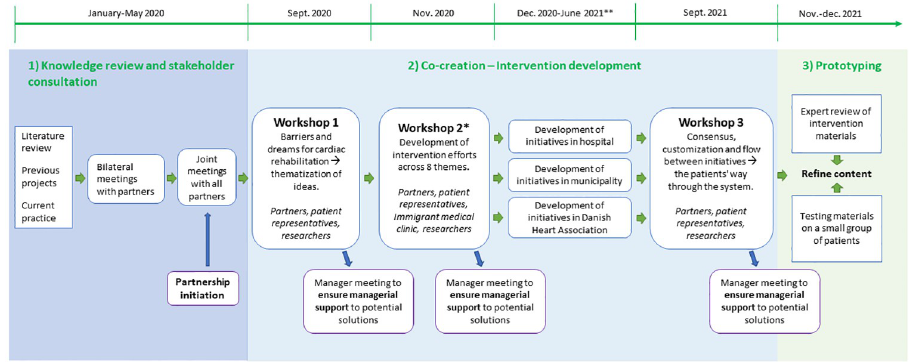
Fig 3. Framework for co-creation and prototyping in a complex intervention. � Virtual workshop do to Covid-19. �� The Cardiac Outpatient Clinic staff were moved to Covid-care (January-April).